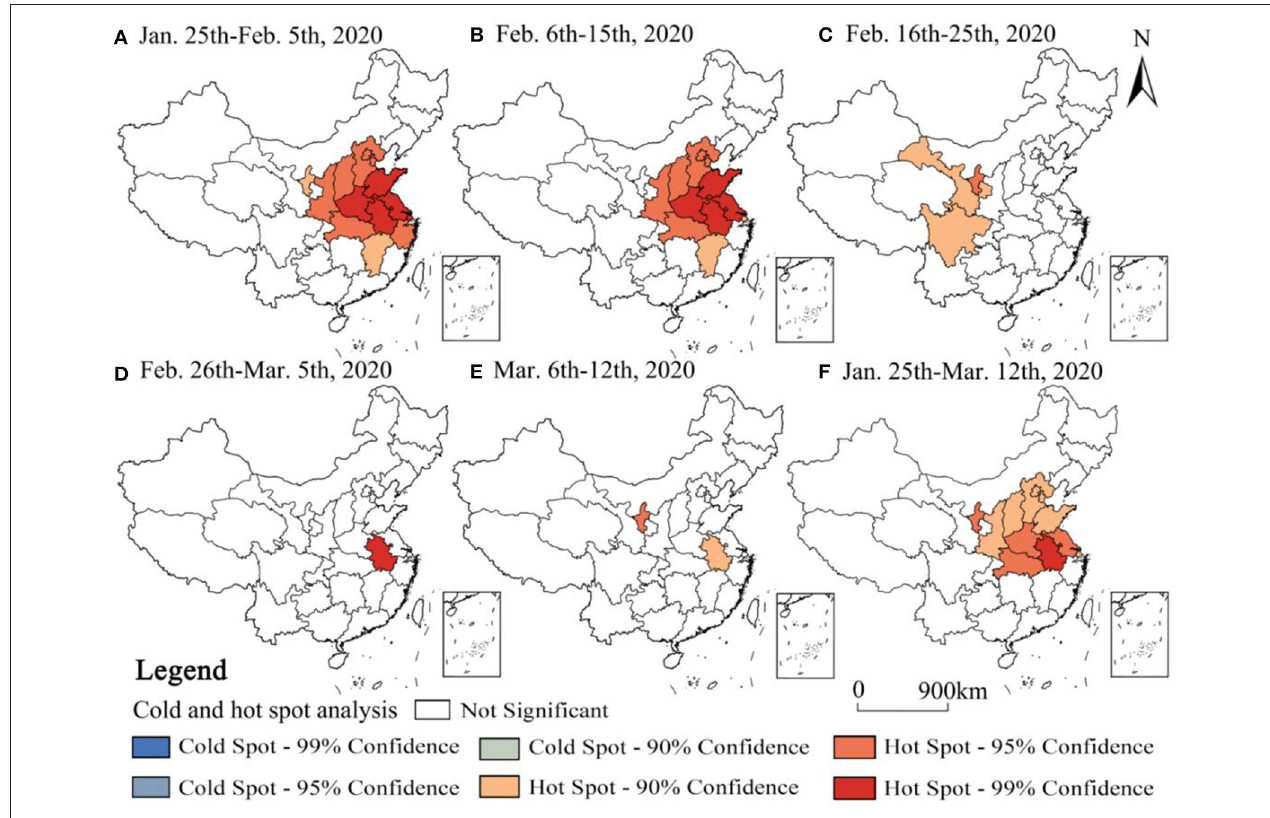
FIGURE 9 | Analysis of hot spots in provincial spatial distribution of short-video